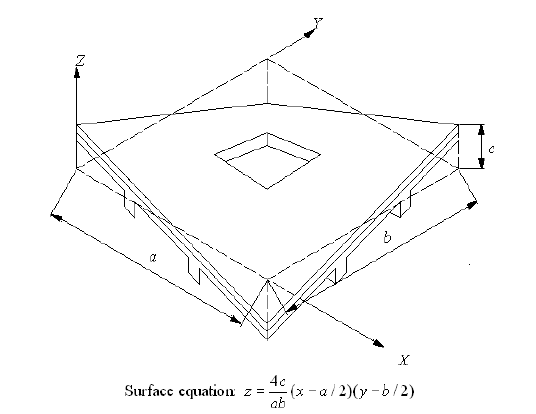
Figure 1: Surface of a skewed hypar shell with cutout